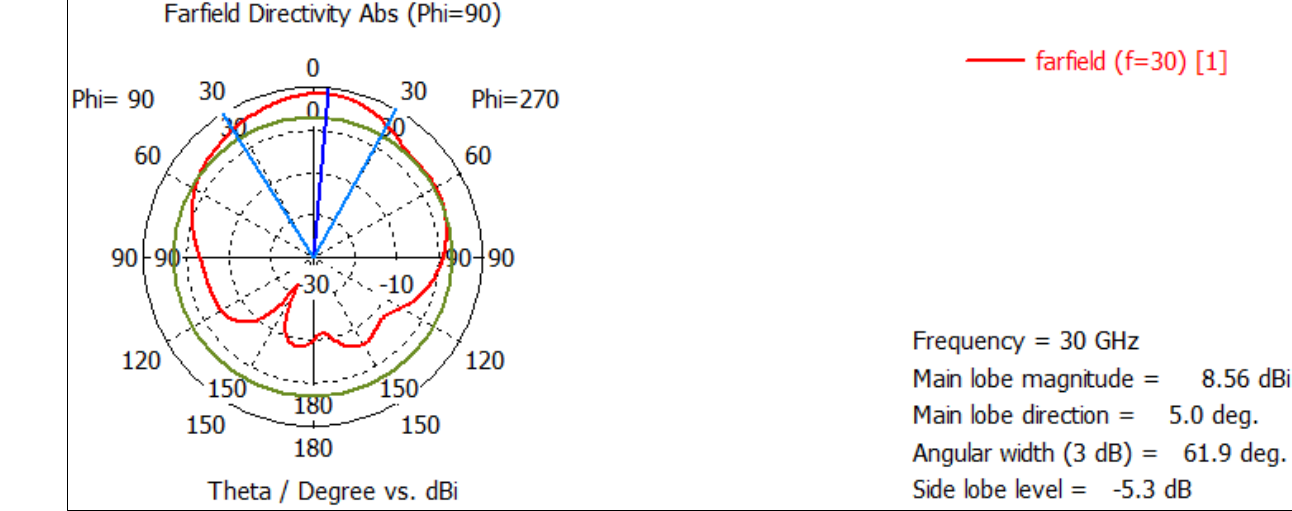
Figure 8. Radiation Pattern